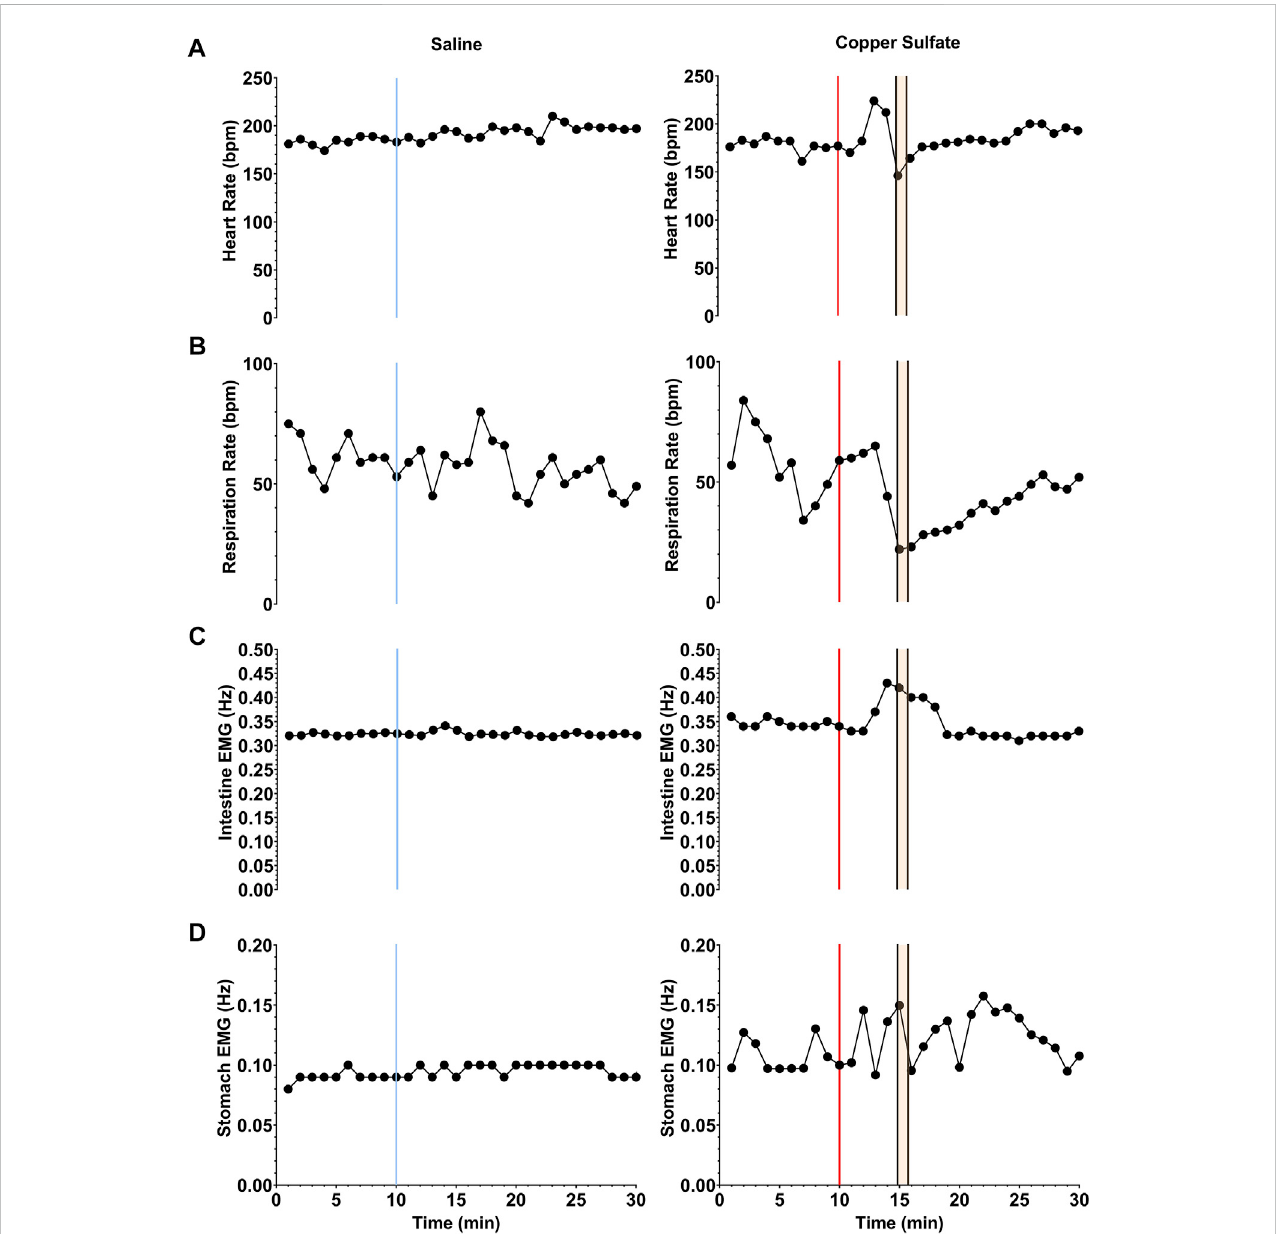
FIGURE 4 Changesinheartrate (A) ,respirationrate (B) ,andthefrequencyofslowwaveactivityintheduodenum (C) andstomach (D) elicitedbysaline(leftcolumn) and CuSO 4 (right column) administration in one animal. Each data point indicates averaged data over a 1-s period. The vertical blue line in the left column denotes the time of saline administration, whereas the vertical red line in the right column shows when CuSO 4 was provided. The time period when retching occurred following CuSO 4 administration is designated by gold shading and black vertical